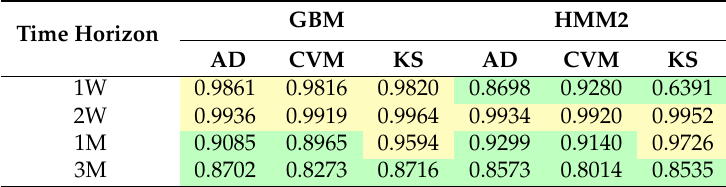
Table 2. Backtesting results for GBP/EUR with calibration window T c = 3 years, frequency of re-calibration δ c = 3 months, and backtesting window T b = 10 years.